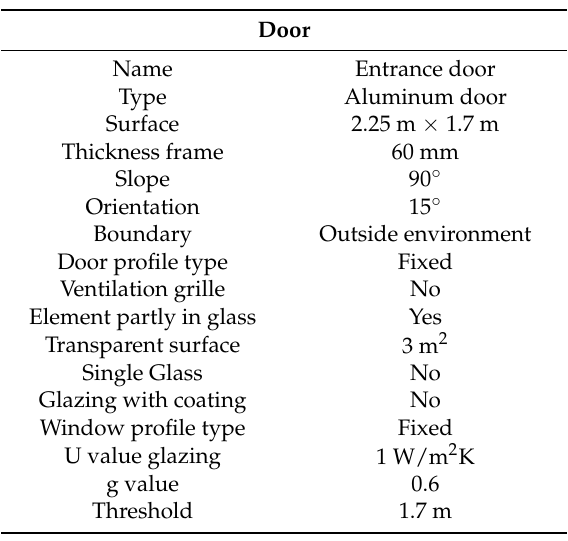
Table 7. Extracted data of one door out of the